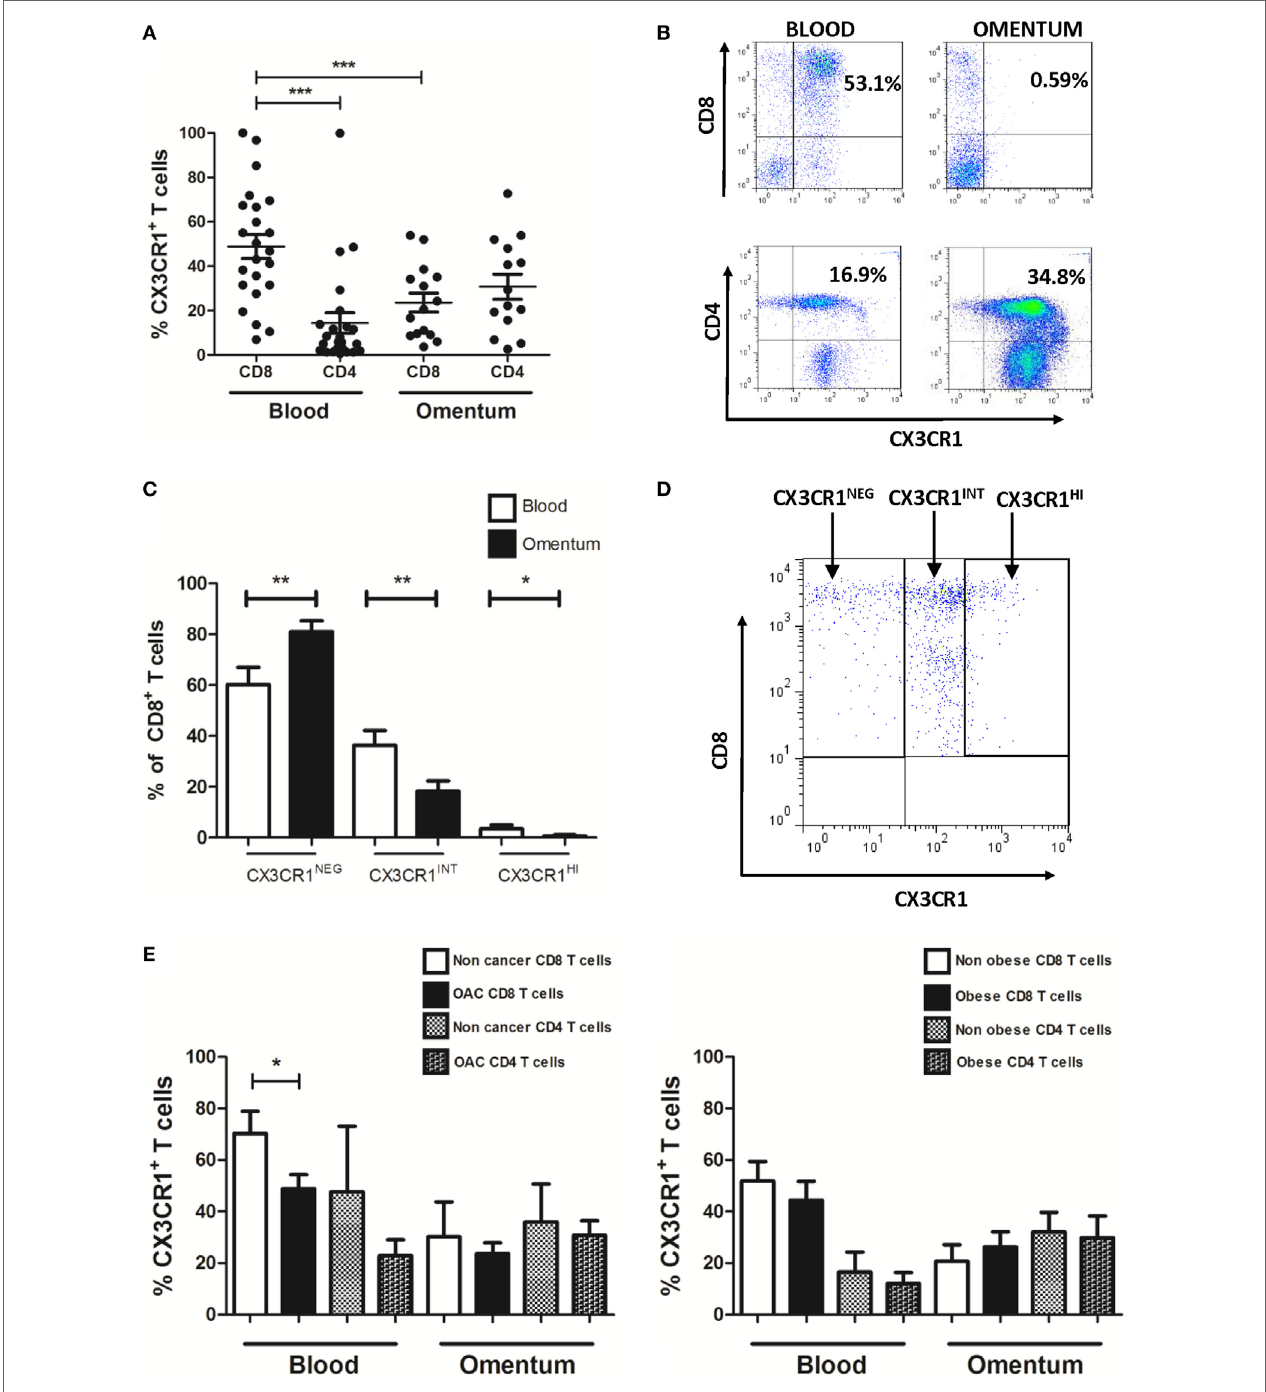
FigUre 2 | Frequencies of CX3CR1 + CD8 + T cells are significantly lower in omentum of esophagogastric adenocarcinoma (EAC) patients compared to frequencies of both peripheral blood CX3CR1 + CD8 + T cells and CX3CR1 + CD4 + T cells. Peripheral blood mononuclear cells and stromal vascular fraction of omentum were isolated from EAC patients. (a) Scatterplots show the frequencies of CX3CR1 + CD8 + and CD4 + T cells in the blood and omentum of a total of 24 EAC patients. (B) Representative dot plots of CX3CR1 + CD8 + and CX3CR1 + CD4 + T cells (gated on and shown as a percentage of total CD3 + population) in blood and omentum. (c) Bar chart showing the frequencies of CD8 + cells expressing no CX3CR1 (CX3CR1 NEG ), intermediate (CX3CR1 INT ), and high levels of CX3CR1 (CX3CR1 HI ) in the blood (white) and omentum (black) of 24 EAC patients. (D) Representative dot plot of circulating CD8 + T cells expressing no CX3CR1 (CX3CR1 NEG ), intermediate levels of CX3CR1 (CX3CR1 INT ), and high levels of CX3CR1 (CX3CR1 HI ). (e) Bar charts showing the CX3CR1 + CD8 + and CD4 + T cells in the blood and omentum of 8 non-cancer control subjects and 24 EAC patients (left) and 14 non-obese and 10 obese EAC patients (right). * p < 0.05, * p < 0.01, *** p < 0.001 by paired and unpaired t